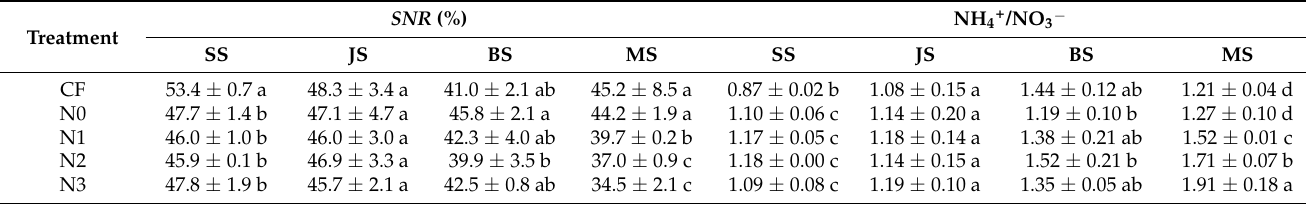
Table 3. The SNR and NH 4+ /NO 3 − as affected by the application of substitute organic fertilizer for chemical fertilizer and stage fertilization. Different lowercase letters in the same column indicate a significant difference between treatments at p < 0.05 level. Note: SS, seeding stage; JS, jointing stage; BS, booting stage; MS, mature stage.